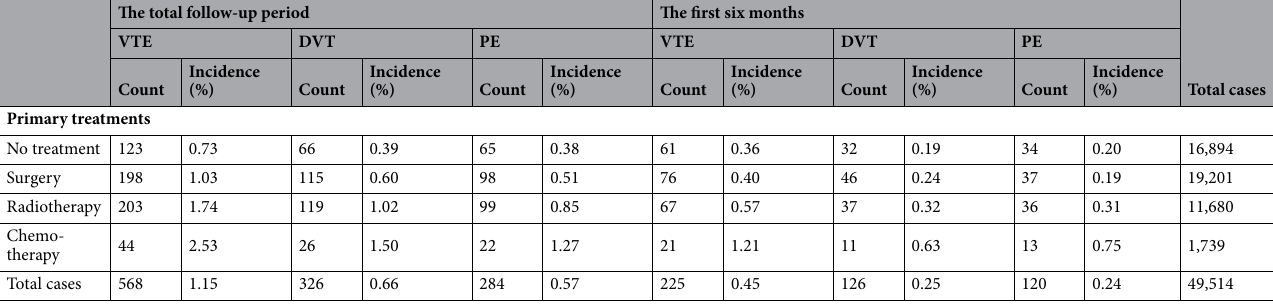
Table 2. Incidence of VTE according to various primary treatments in patients with cervical cancer (HIRA claims data of 2009–2018).